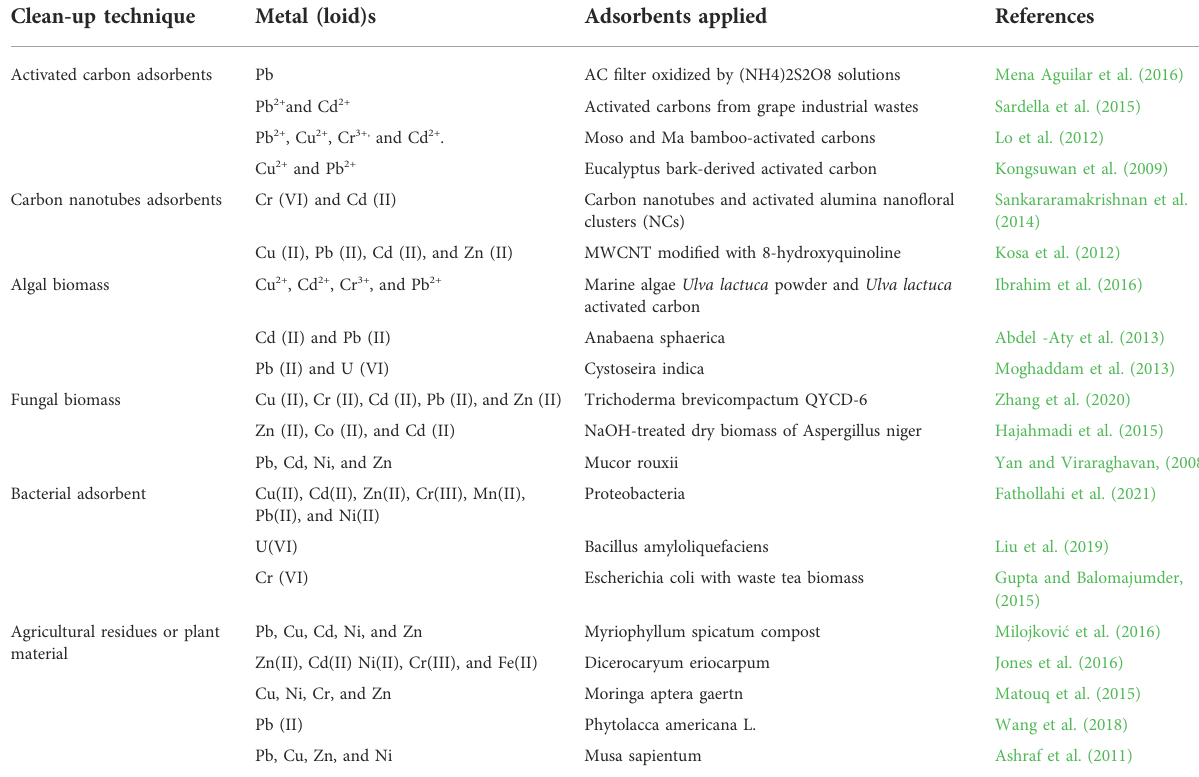
TABLE 6 The application of different adsorbents for the removal of metal